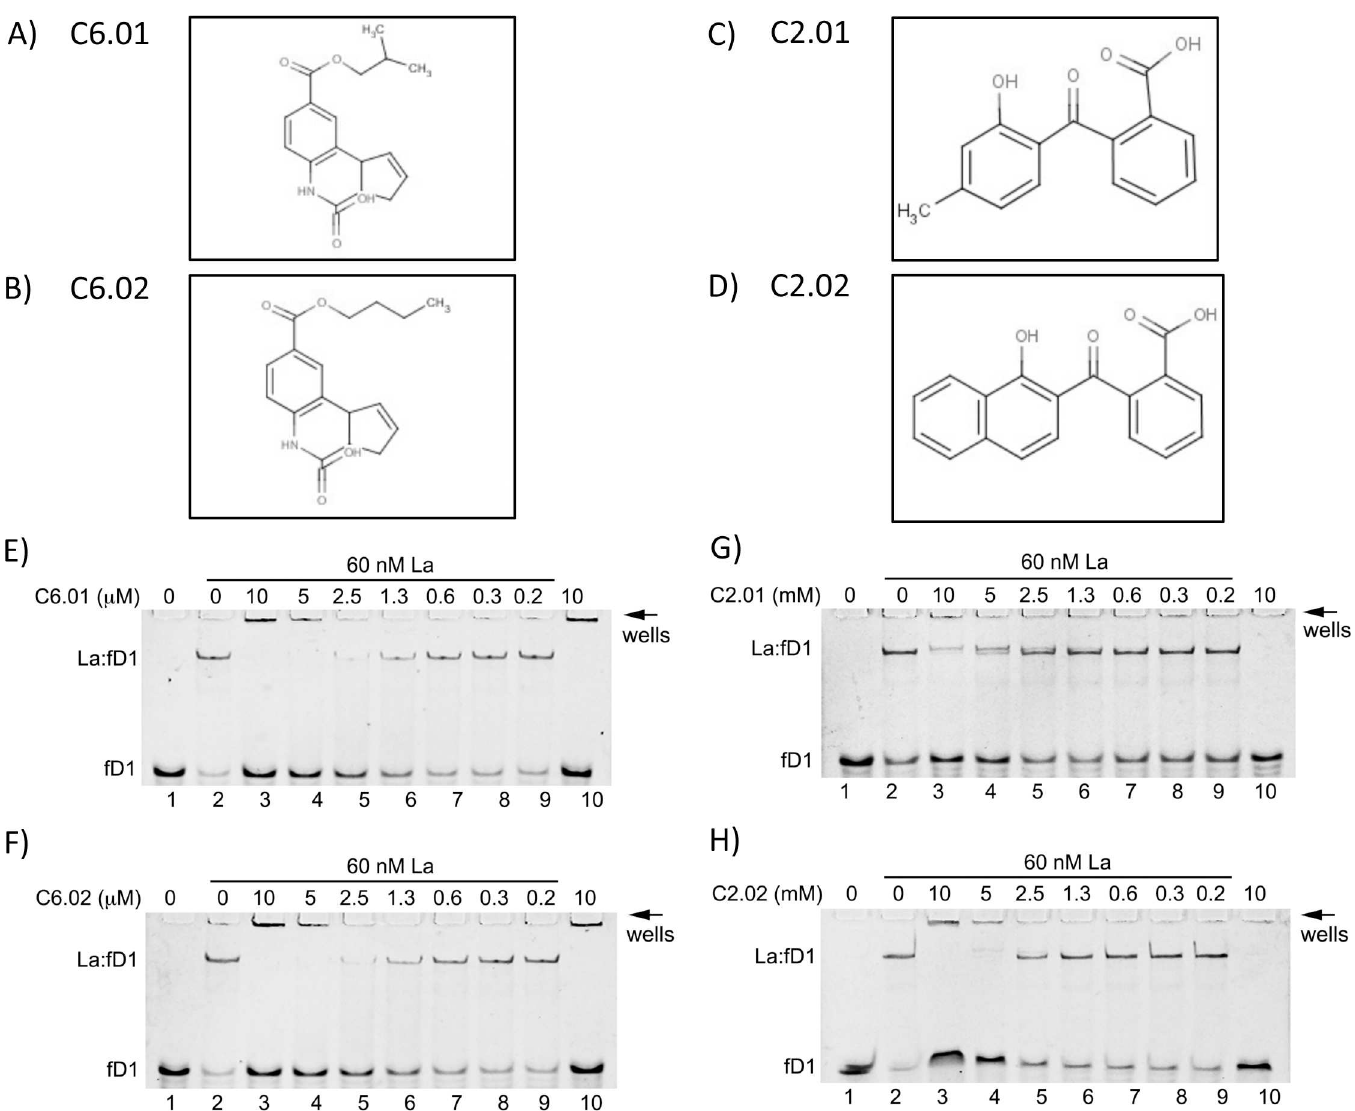
Fig 5. The 2D analogs C6.01, C6.02 and C2.01, C2.02 compete for La binding to fD1-RNA. Chemicalstructure of 2D analogsof C6 and C2, respectively, are shown: C6.01 (A) , C6.02 (B) , and C2.01 (C) , C2.02 (D) . Constant concentration of recombinant La protein (60 nM) and fluorescence labeledRNA oligonucleotides (50 nM) was used with increasingconcentrations of compoundC6.01, C6.02, C2.01 or C2.02. Lanes 1 and 2 containedthe highestvehicle (DMSO) concentration used with the compounds. The compoundwas first incubatedwith La and RNA oligonucleotides were quickly added thereafter. Lane 10 containsthe fluorescence labeledRNA oligonucleotides and the highestconcentration of compoundtested. Reactionswere analyzedon a 10% native polyacrylamide gel and representative gels of independent experiments are shown. E) fD1-RNA, La-WT and decreasing concentrations of C6.01, F) fD1-RNA, La-WT and decreasingconcentrations of C6.02, G) fD1-RNA, La-WT and decreasing concentrations of C2.01, and H) fD1-RNA, La-WT and decreasing concentrations of C2.02. All experiments were performed at least